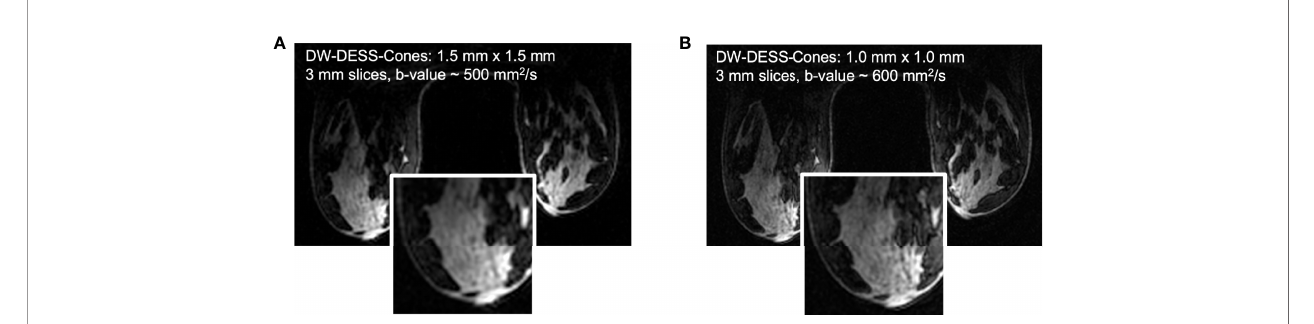
FIGURE 5 | Based on the results of the initial DW-DESS-Cones investigation in the breast at 3T (A) , the diffusion-weighting and resolution of the method can be further increased (B) to better match contrast and resolution expectations for breast MRI (109). (Courtesy of Catherine Moran, PhD, Department of Radiology, Stanford University, Stanford,